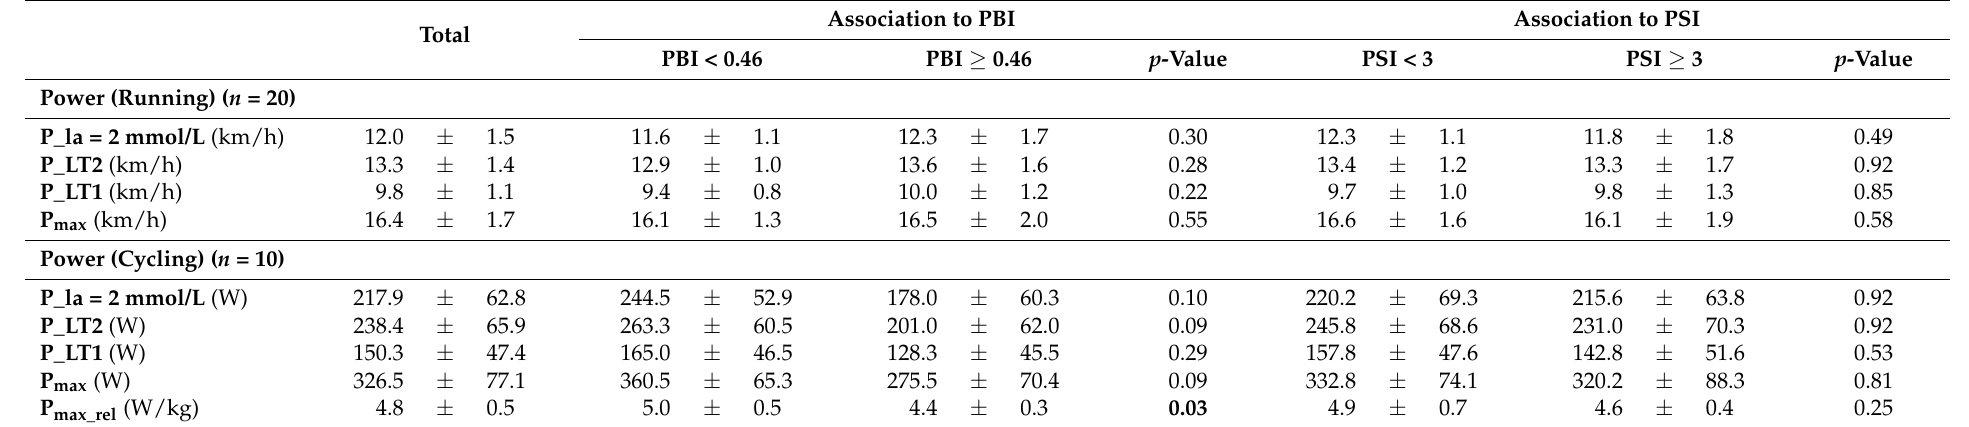
Table 6. Power on ergometer during incremental exercise tests and their association with periodontal health (PBI and